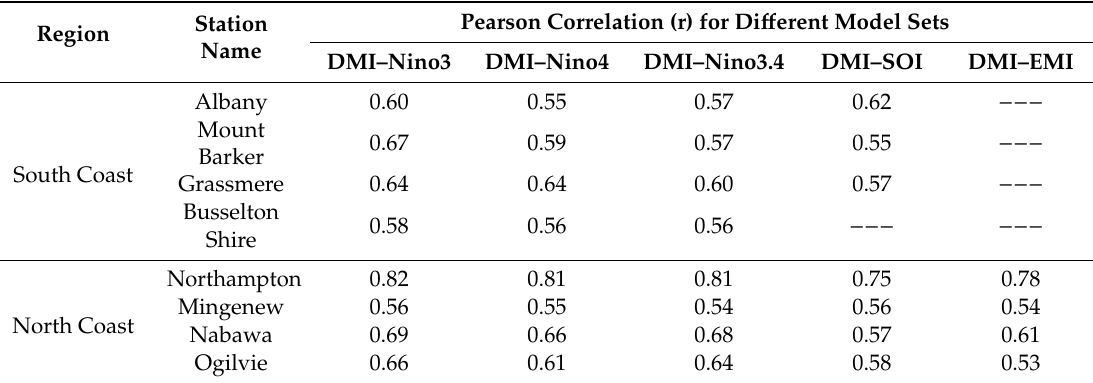
Table 5. Pearson correlation (r) results with the di ff erent model sets in ARIMAX.